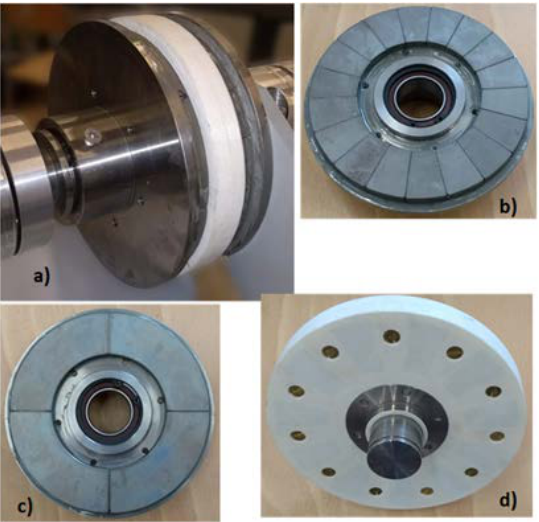
Figure 1. ( a ) AFMG prototype (MG 2 : 2/11/9 G R 2 = 5.5), ( b , c ) low- and high-speed rotors, respectively, ( d ) made using additive technology modulator containing SMC cores.